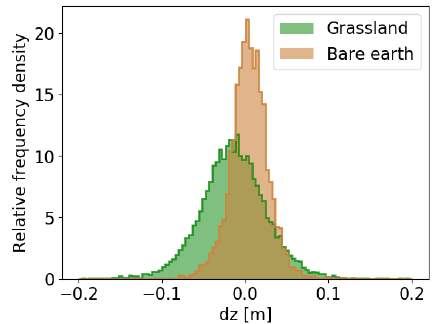
Figure 5. Relative frequency density of elevation differences (dz) between the ULS DSM and the TLS DSM for grassland and bare earth samples.